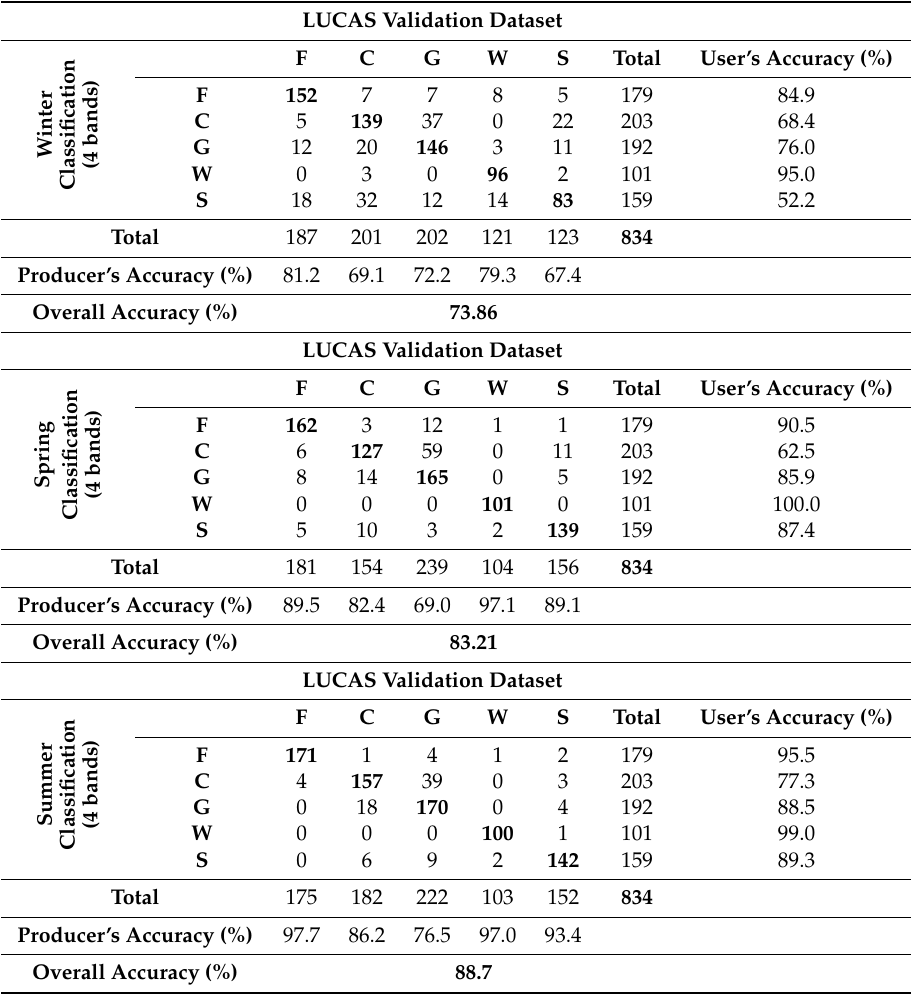
Table 3. The three-season confusion matrixes with four spectral bands (B2, B3, B4, and B8). ( a ) Winter classification; ( b ) spring classification; ( c ) summer classification. The reference data used here were the LUCAS validation dataset with 834 points. The summer classification yielded the best OA with 88.7%, followed by the spring classification (83.2%) and winter classification (73.9%).